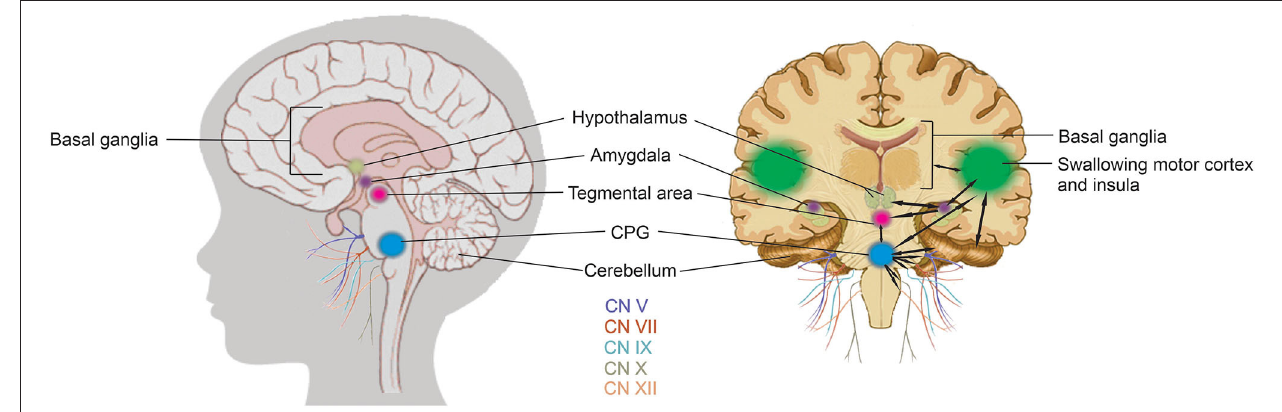
FIGURE 6 | Sucking and swallowing brain network. Sucking and swallowing is a bilateral process in the brain, each hemisphere has been shown to act both contralaterally and ipsilaterally, therefore, for simplicity, the black arrows on the right, coronal view of the brain indicate the complex integration and communication between the areas in only one hemisphere currently believed to be involved in the motor aspects of sucking. CPGs (blue), are at the core of this complex system. A second level of controls includes subcortical structures including the basal ganglia, hypothalamus (pale olive green), cerebellum, amygdala (purple), and tegmental area (pink) of the midbrain with a third level in the suprabulbar cortical swallowing center and insula (green). The cranial nerves (CN) required for the motor process of feeding and swallowing include CN V and VII to move the jaw and facial muscles, CN XII for tongue movement, CN V, IX, and X for movement of the epiglottis, expansion of the uvula and elevation of the hyoid bone and larynx, and CN X for peristaltic movement of the esophageal